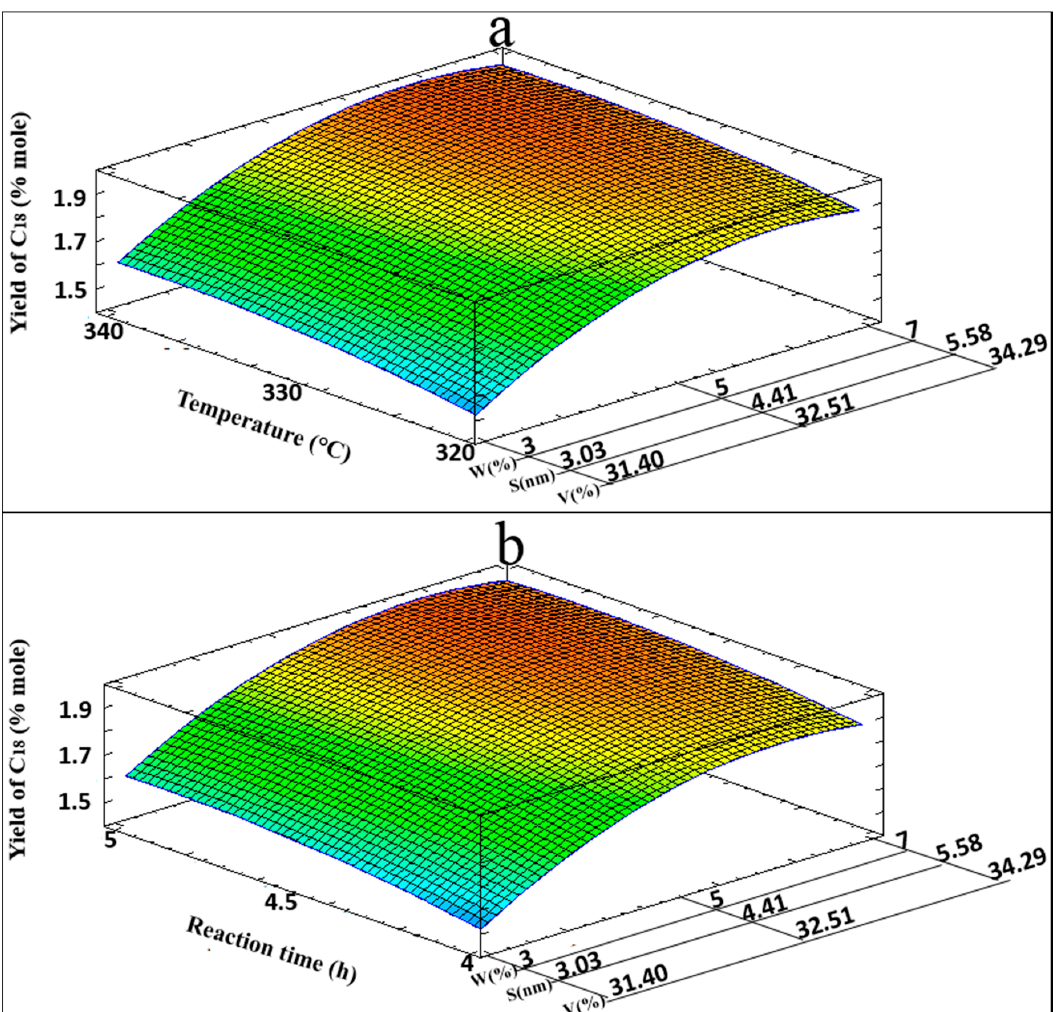
Figure 7. 3D response surface for n -C 18 yield combining: ( a ) T, W, S, and V; ( b ) t, W, S, and